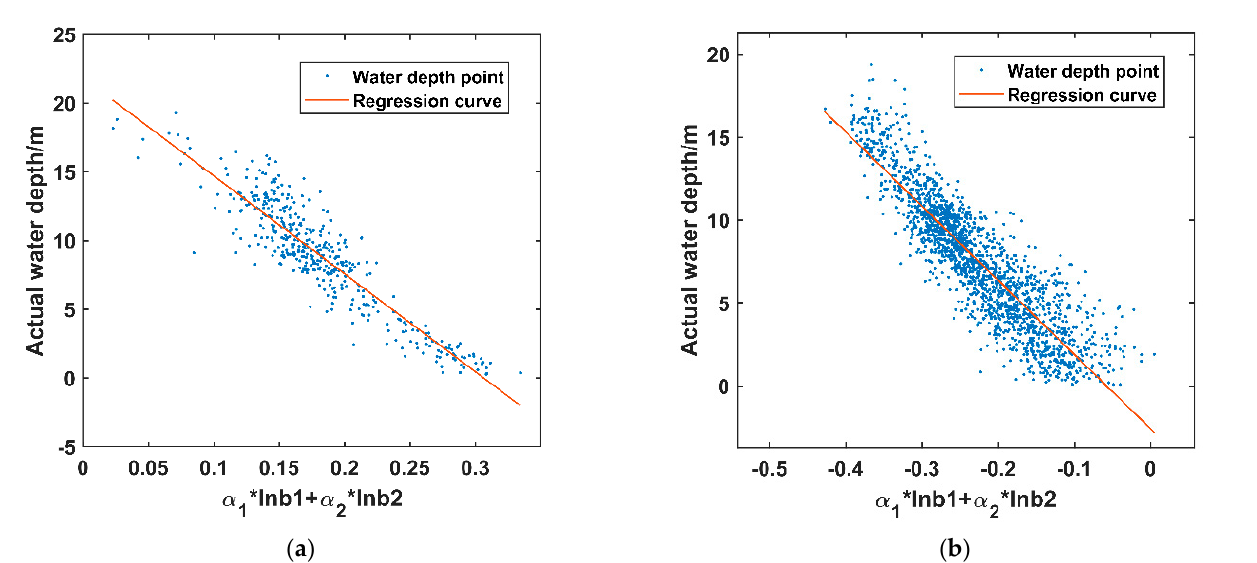
Figure 11. Scatter plots of 𝛼 (cid:2869) 𝑋 (cid:2869) + 𝛼 (cid:2870) 𝑋 (cid:2870) and the actual water depth: ( a ) Ganquan Island, ( b ) Zhaoshu Island. Corresponding data on 𝛼 (cid:2869) 𝑋 (cid:2869) + 𝛼 (cid:2870) 𝑋 (cid:2870) was obtained by the linear combination of [ α 1 , α 2 ] (the unit vector of a different angle of rotations) and X 1 ∼ X 2 (the spectral dataset) to calculate the correlations between 𝛼 (cid:2869) 𝑋 (cid:2869) + 𝛼 (cid:2870) 𝑋 (cid:2870) and the actual water depth at varying angles (Figure 12). The rotation angles (0–90 degrees) are separated by 1°. The results sug- gest that when [𝛼 (cid:2869) , 𝛼 (cid:2870) ] (the optimal band rotation coefficient unit vector) corresponds to the angle of rotations around 42° and 43°, the maximum coefficient of determination, R2, between 𝛼 (cid:2869) 𝑋 (cid:2869) + 𝛼 (cid:2870) 𝑋 (cid:2870) and the water depth was 0.893 for Ganquan Island and 0.803 for Zhaoshu Island. Under the ideal state, the R 2 between 𝛼 (cid:2869) 𝑋 (cid:2869) + 𝛼 (cid:2870) 𝑋 (cid:2870) and water depth should be approximately one after applying the optimal band rotation coefficient unit vector.